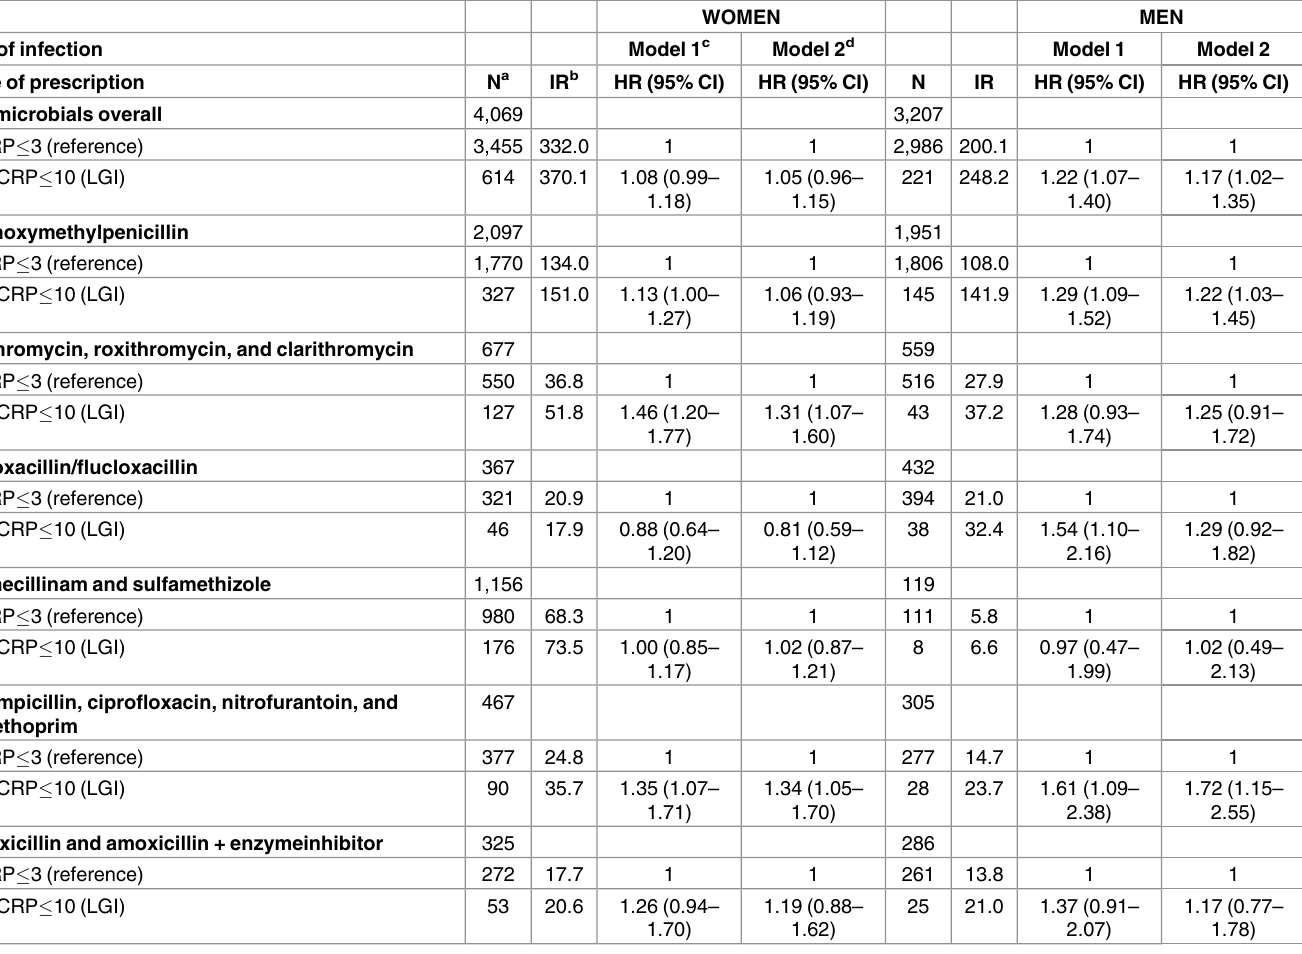
Table 3. The association between low-grade inflammation and prescriptions of